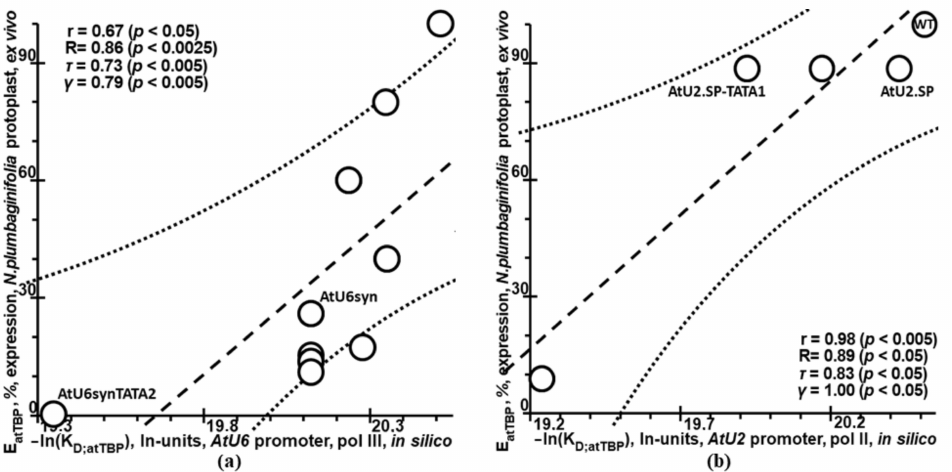
Figure 5. Verification of Plant_SNP_TATA_Z-tester using experimental data on the plant gene synthetic artificial proximal promoters designed on the basis of natural ones (datasets 9 and 10). ( a ) The synthetic artificial promoter designed on the basis of the thale cress U6-26 snRNA gene promoter, Pol III, and tobacco protoplasts ex vivo [51]. ( b ) The synthetic artificial promoter designed on the basis of the thale cress U2.2 snRNA gene promoter, Pol II, and tobacco protoplasts ex vivo